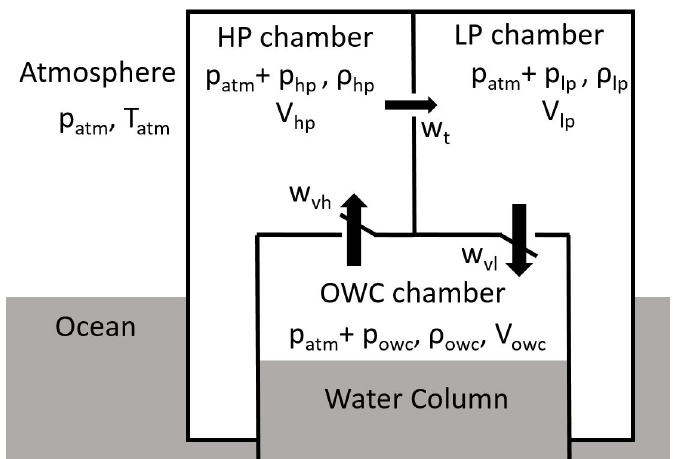
Figure 4. Tupperwave device schematic with thermodynamic